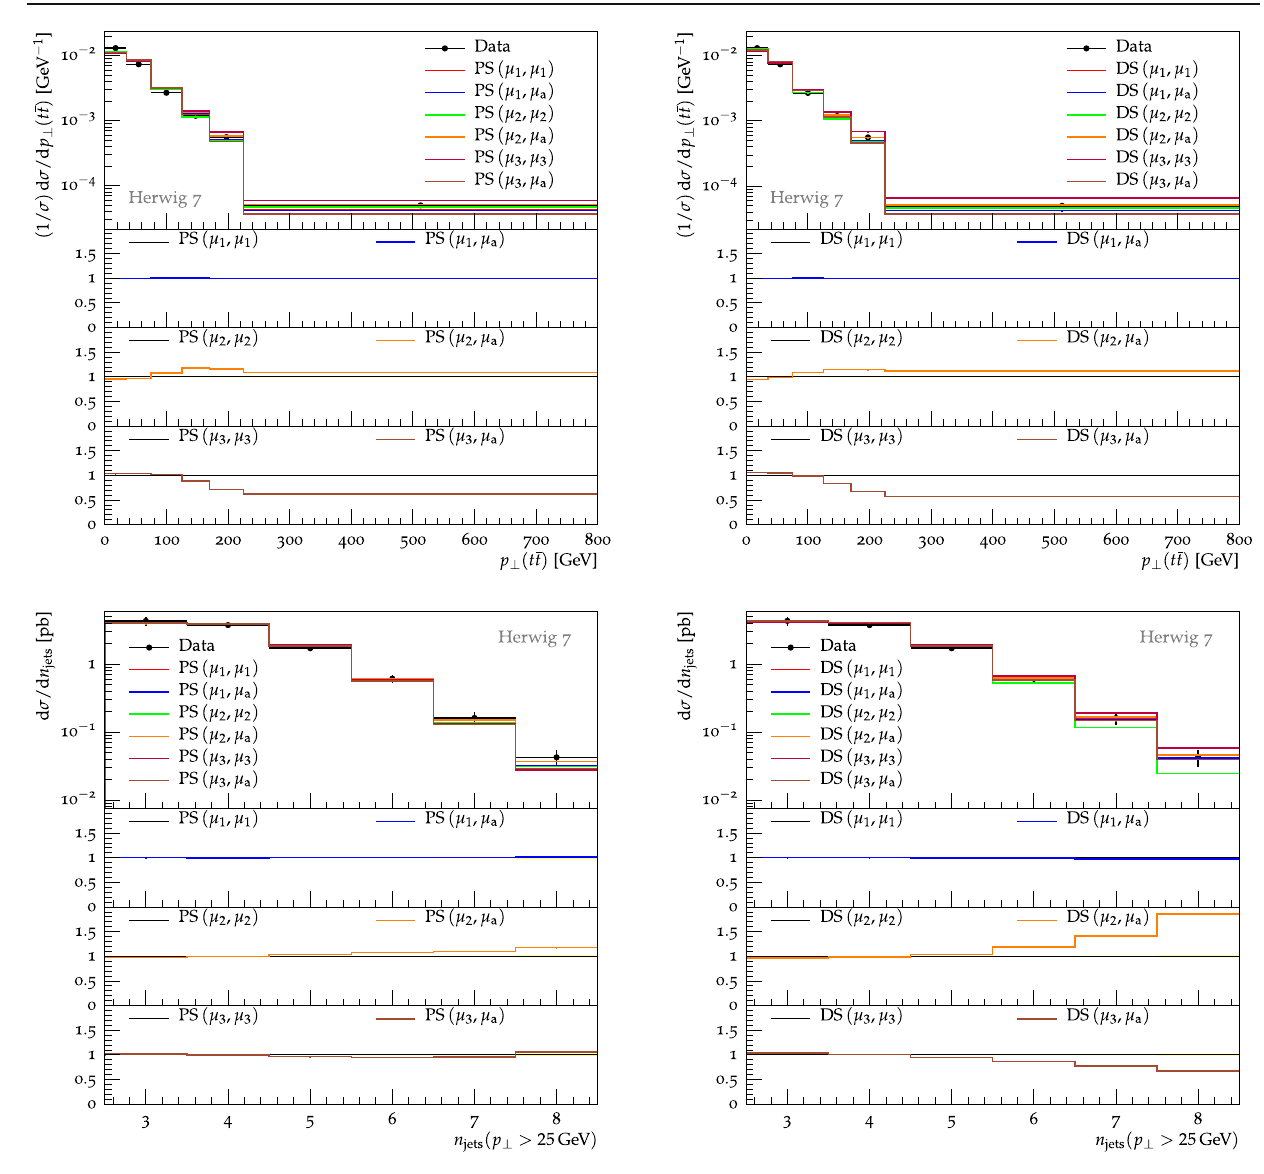
tom: The multiplicity distribution of jets with p ⊥ > 25 GeV measured by ATLAS in semileptonic 7TeV pp → t ¯ t events [63] and predicted using the angular-ordered and dipole parton showers,